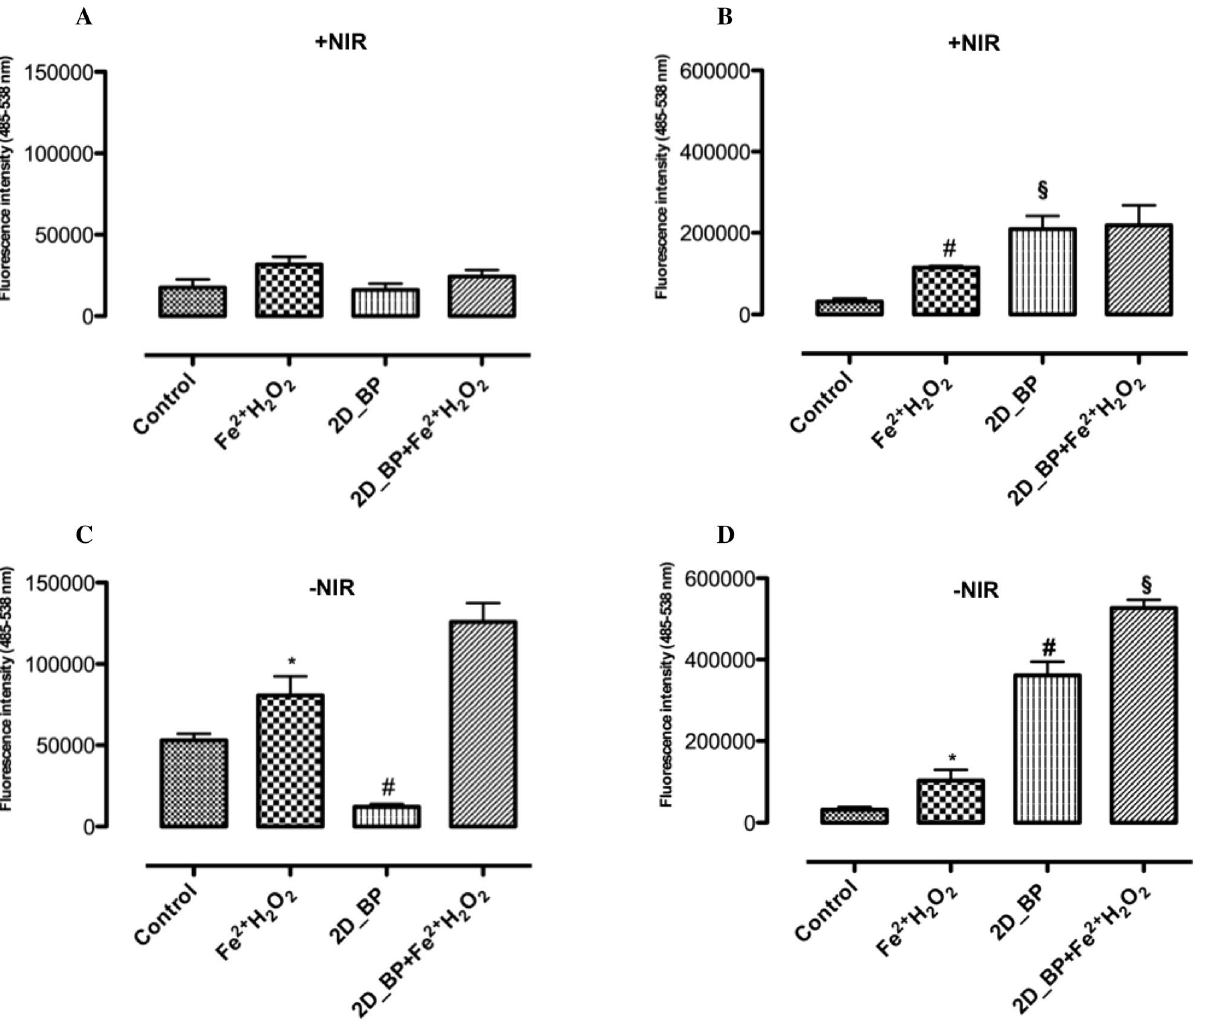
Figure 4. Reactive Oxygen Species (ROS) production from PNT-2 ( A , C ) and PC-3 ( B , D ) cells with (+ NIR) and without infrared (-NIR) irradiation. The exposure of PNT-2 and PC-3 cells (healthy and cancer cells) to H 2 O 2 /Fe 2+ (2 mM) significantly (* p ≤ 0.05, # p ≤ 0.0001) increases ROS production compared to control ( A – D ). As irradiated 2D BP with H 2 O 2 /Fe 2+ (2 mM) irradiated 2D BP without H 2 O 2 /Fe 2+ (2 mM) stimulation was able to induce a significant ( #,§ p ≤ 0.0001) increase in ROS generation in PC-3 cells ( B , D ). Not irradiated 2D BP significantly (# p ≤ 0.0001) reduced basal ROS levels compared to control on PNT-2 cell line ( C ). Conversely, not irradiated 2D BP did not inhibit ROS generation induced by H 2 O 2 /Fe 2+ (2 mM) in PNT-2 cells compared to H 2 O 2 /Fe 2+ (2 mM) alone ( C ). Results are mean ± SEM of 3–4